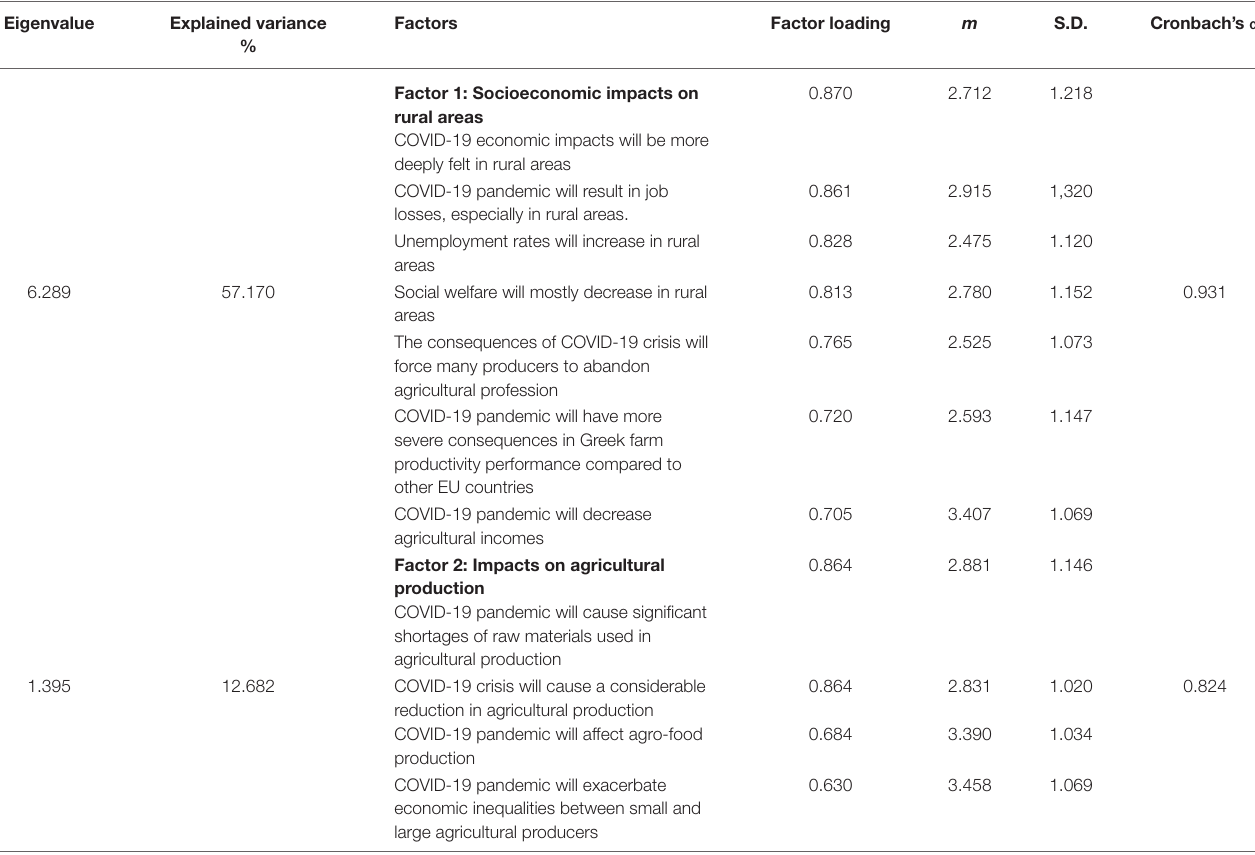
Eigenvalue Explained variance